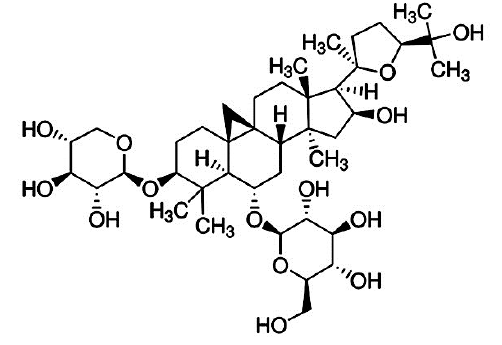
Figure 1. Chemical structure of astragaloside